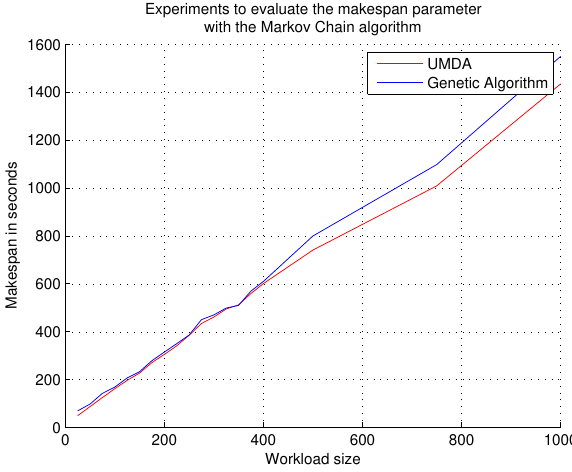
Figure 4. Results of makespan parameter with the Markov chain